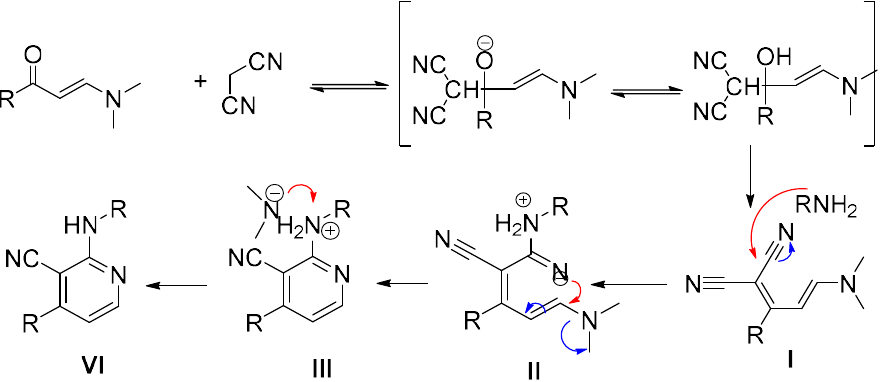
Table 3. Multicomponent synthesis of 2-aminopyridines